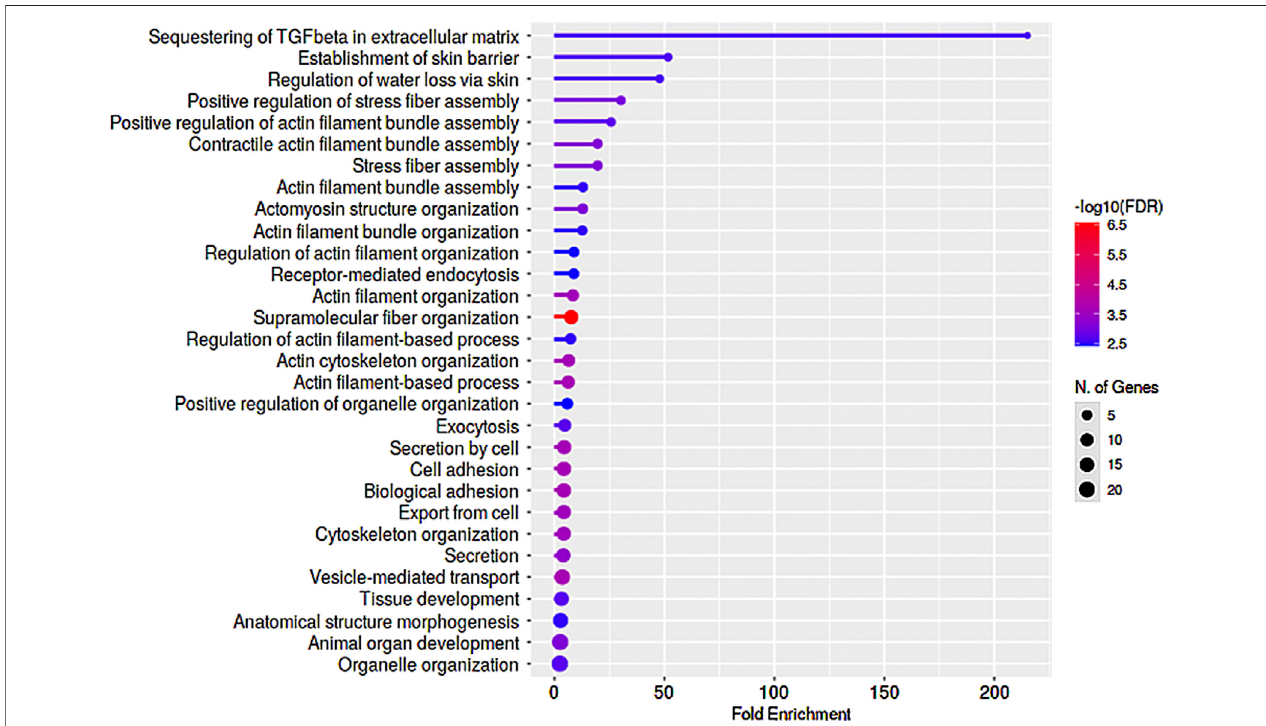
FIGURE 6 | GO enrichment analysis of proteins exhibiting upregulated levels in nuclear protein fractions of human TM cells treated with Dex for 5- and 7-day periods. Several proteins exhibited similar trends ( ≥ 2-fold increase) in changes in levels between the 5- and 7-day Dex treated samples, and enrichment analysis for